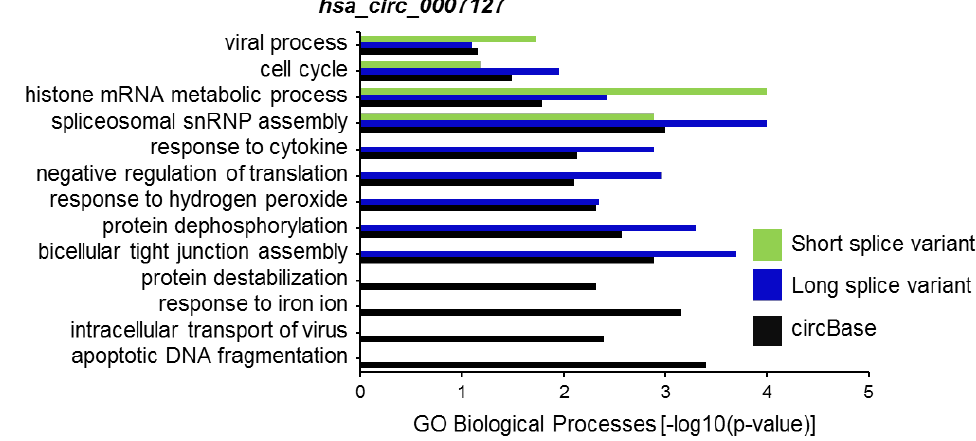
Figure 5. Selected list of biological processes enriched in Gene Ontology (GO) annotation analysis for the target genes of miRNAs associated with the sequence of circBase and splice variants of hsa_circ_0007127 .